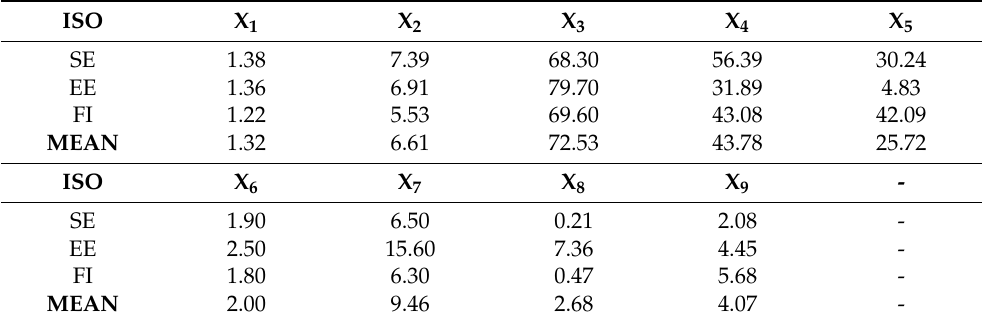
Table 4. “Smart and efficient energy systems”—values of diagnostic variables for countries constituting cluster 1. ISO X